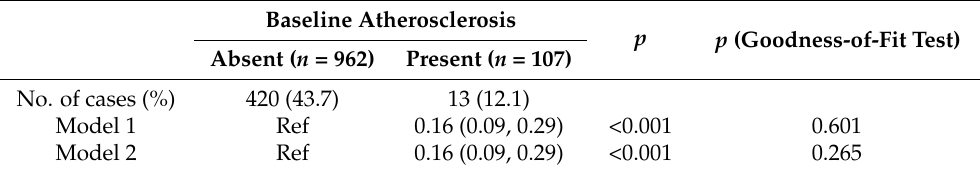
Table 2. Odds ratios (ORs) and 95% confidence intervals (CIs) for active arterial wall thickening by baseline atherosclerosis status.